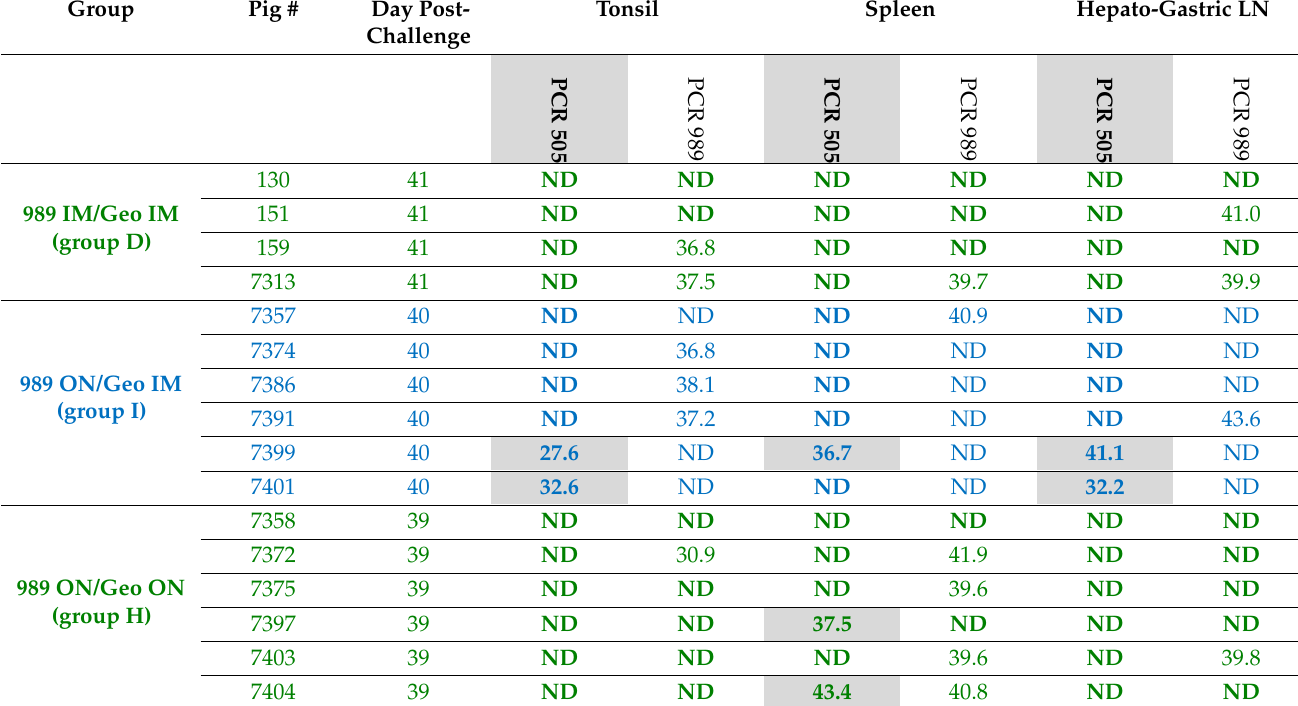
Table 4. Detection of ASFV-989 and Georgia ASFV genome in tissues of immunized or nonimmunized pigs after challenge with Georgia